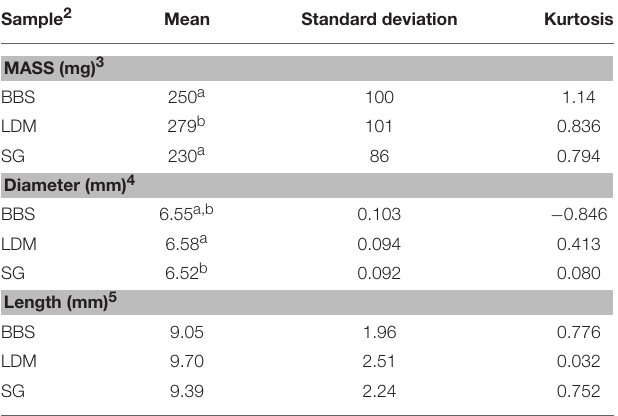
TABLE 1 | Physical properties of pellets 1